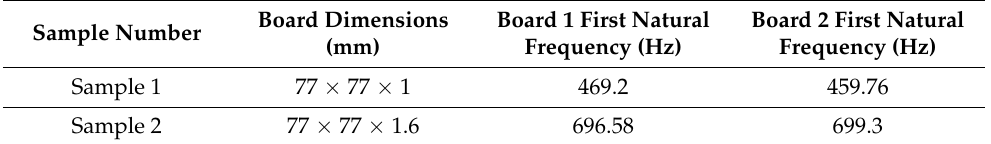
Table 2. First Natural Frequency of the Test